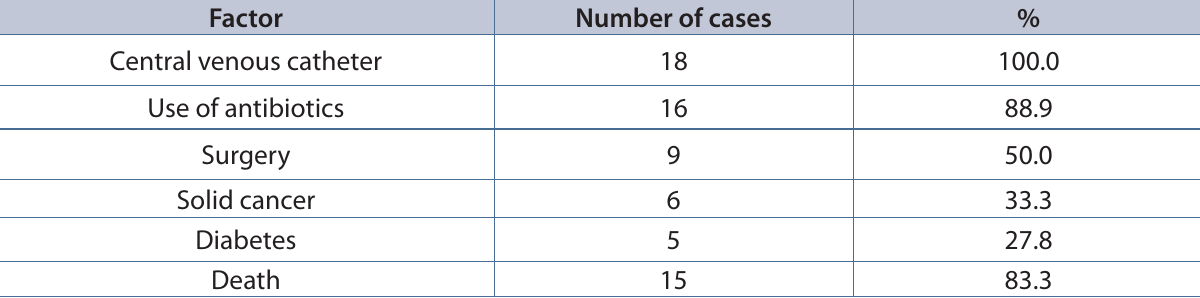
Table 7. Factors associated with candidemia in patients over 60 years old admitted to Botucatu Medical School University Hospital